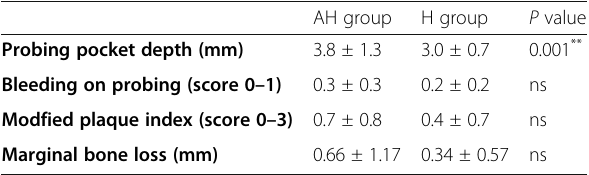
Table 3 Clinical and radiographic parameters